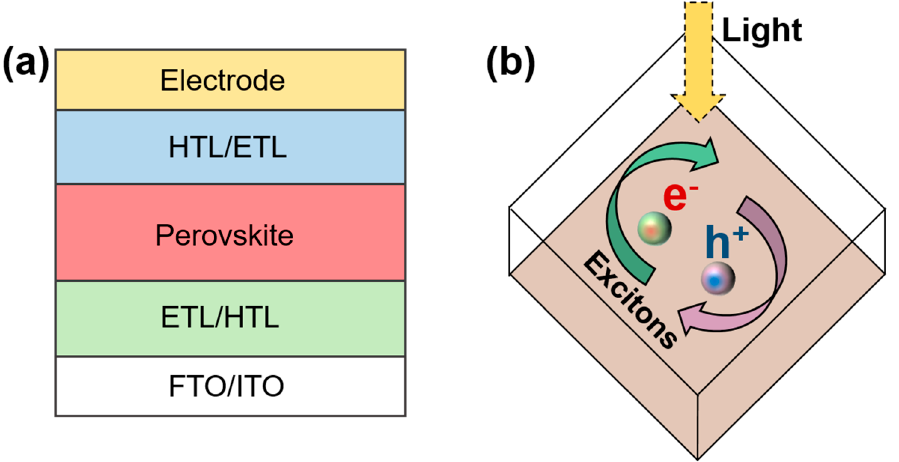
Figure 3. ( a ) Structure of PSC and ( b ) schematic diagram of exciton separation.